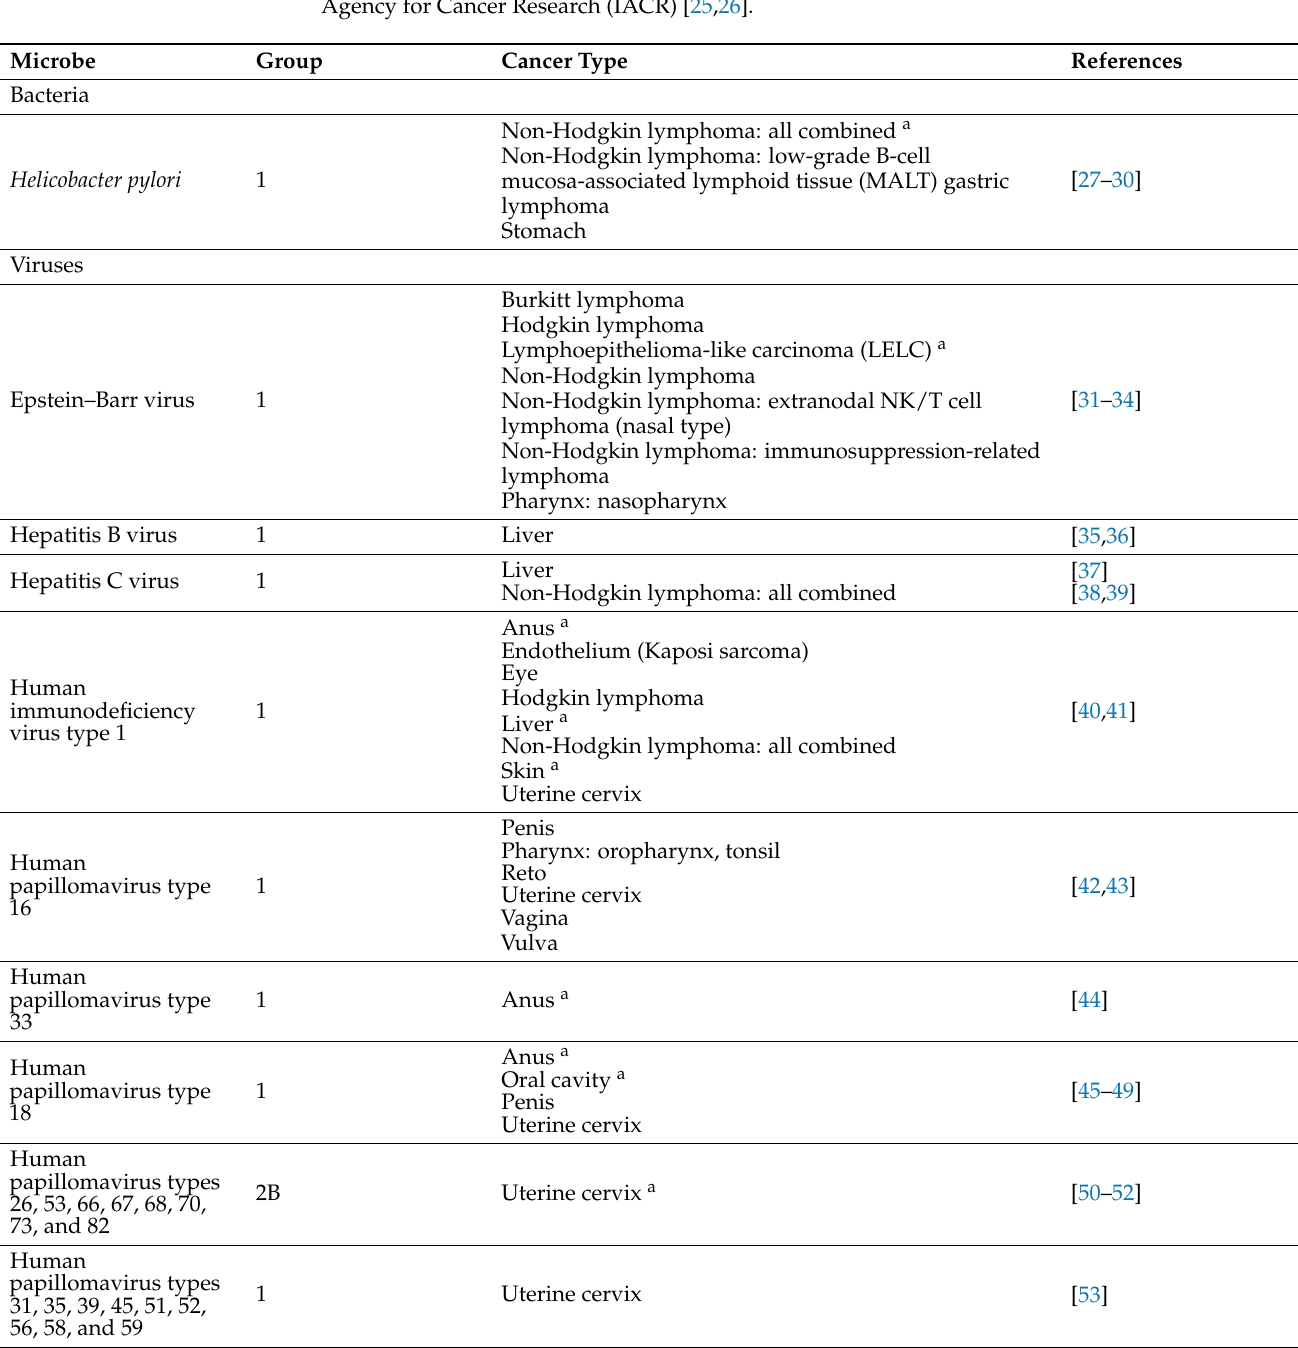
Table 1. List of microbes designated as carcinogenic for humans according to the International Agency for Cancer Research (IACR)